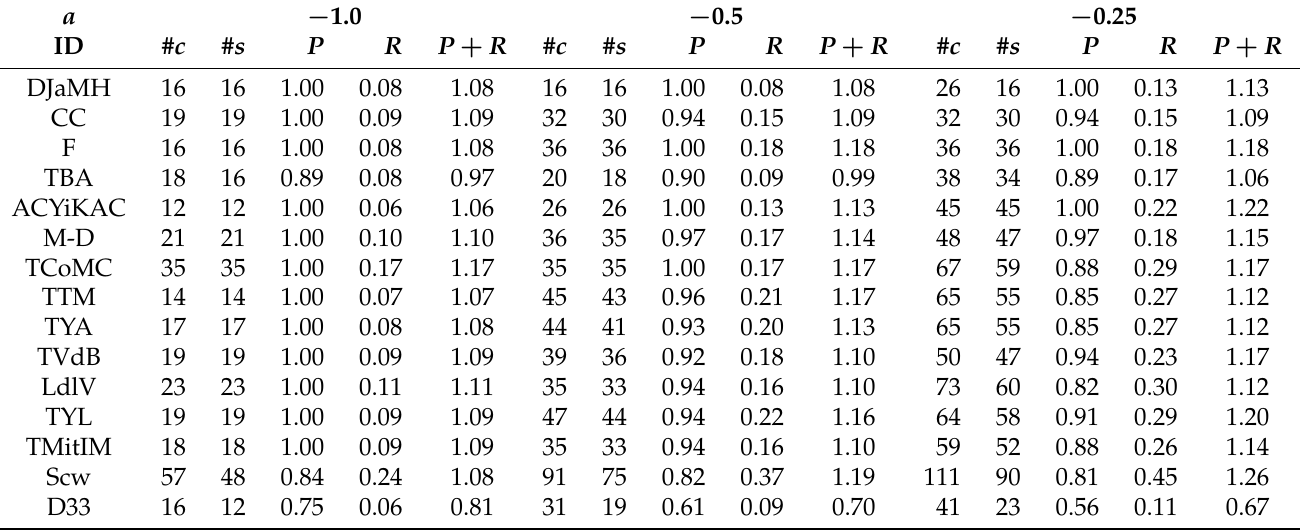
Table 7. Performance of cutoff assessment on single English texts.